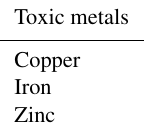
Table 2. List of other toxic metals.